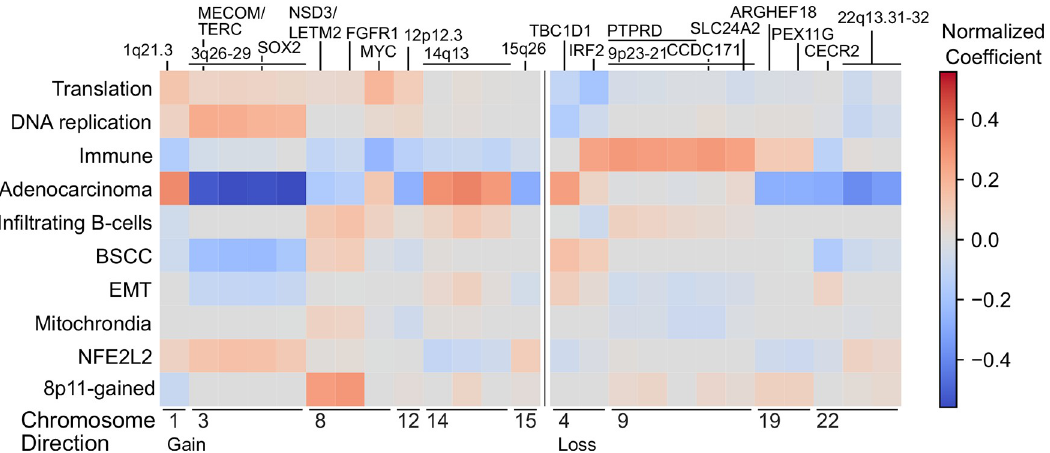
Fig 8. Copy number and factors in the TCGA lung cancer dataset. Normalized coefficients representing the contribution of DNA copy number abberations to the factors. Specifically, the coefficients represent the contribution of recurrently gained (left) or lost (right) copy number regions identified by RUBIC to the factors represented in the rows. Recurrently aberrated copy number regions are annotated with chromosomal bands or putative driver genes in the region.